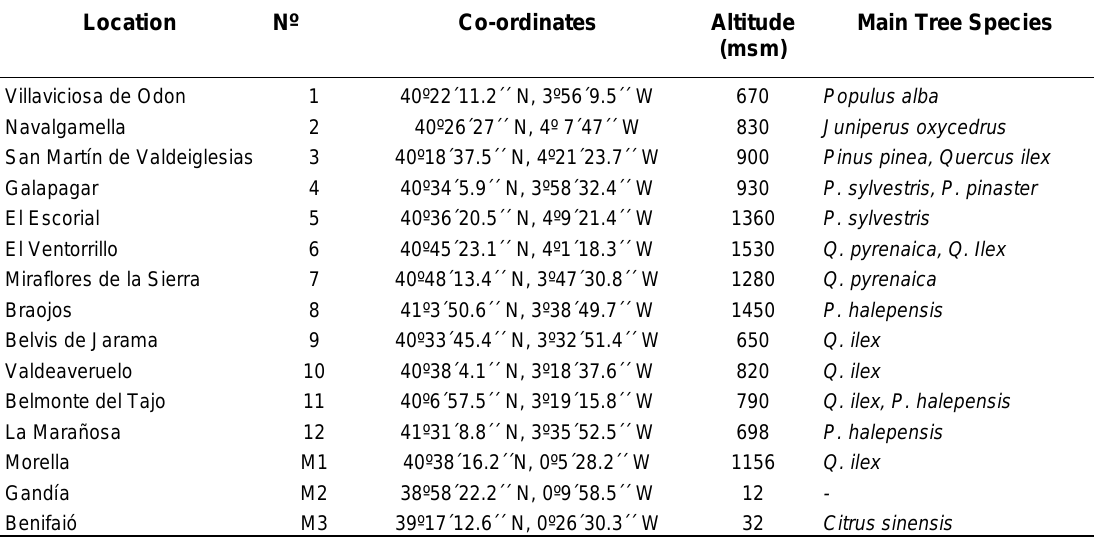
Sampling Locations (1–12) and Continuous Monitoring Stations used for Validation and Correction of the Experimental